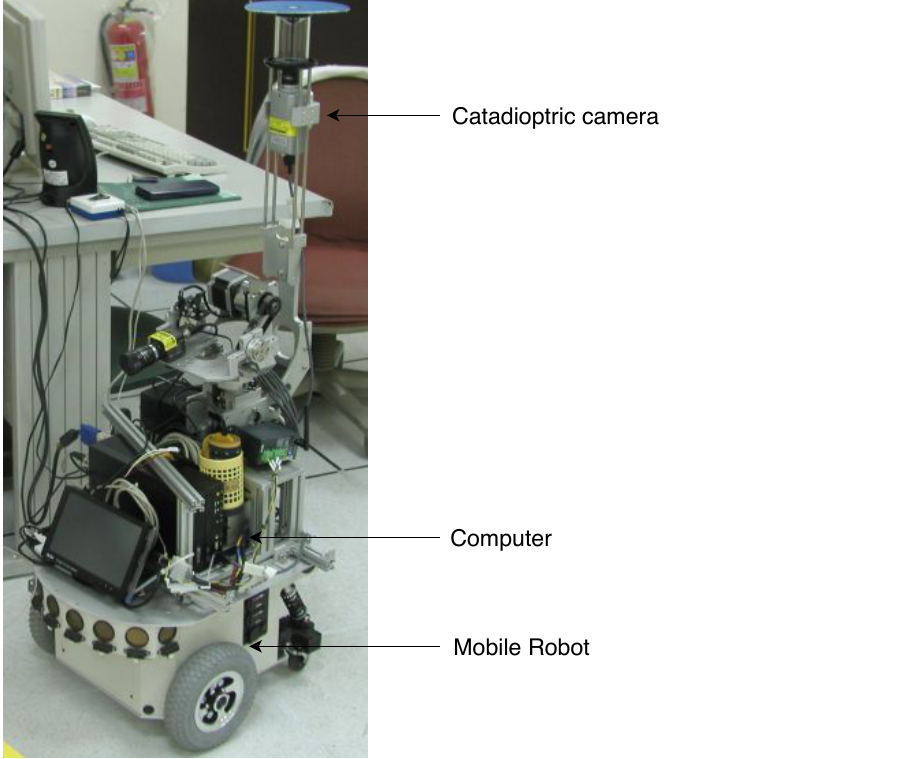
Figure 1. The mobile robot platform used in the experiments. The catadioptric camera mounted on the top of the robot is used for robot self-localization and pose